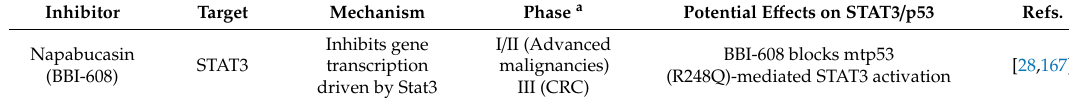
Table 2. Search for potential compounds targeting STAT3 and